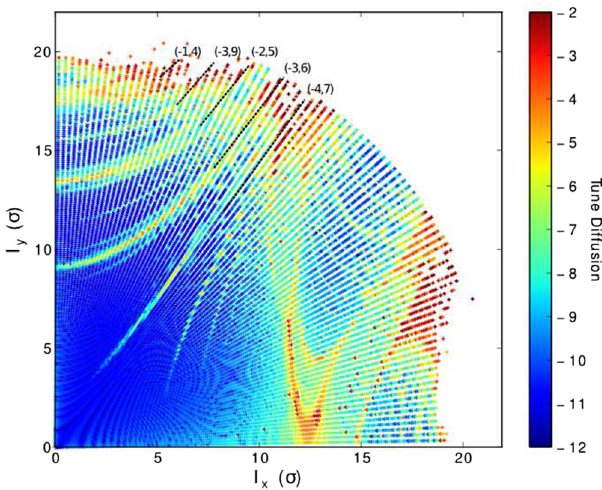
FIG. 20. Diffusion factor D over the initial amplitudes I ¼ 0 – 22 σ and 90 initial angles for the lattice L (cid:1) ¼ 15 m and β (cid:1) ¼ 10 cm.